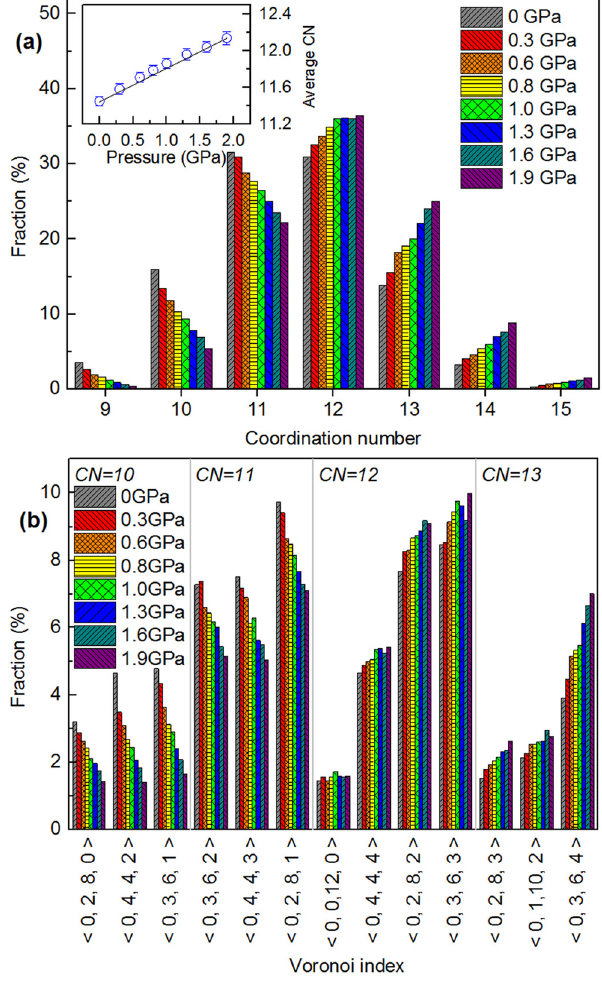
Figure 3. ( a ) The distribution of the CN for liquid gallium at various pressure conditions. The inset illustrates average CN as a function of pressure. ( b ) Fractions of dominant coordination polyhedra at different pressures. Note that only polyhedra with a fraction of > 1.5% are